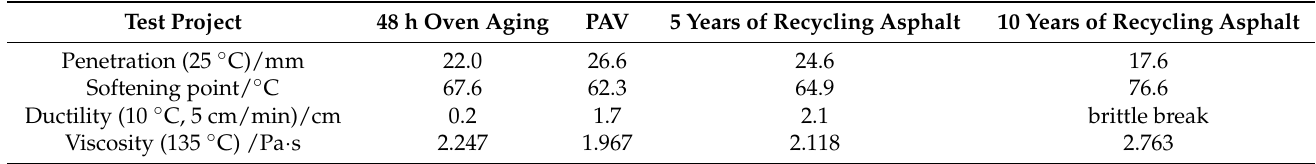
Table 3. Comparison of asphalt performance indexes under different aging